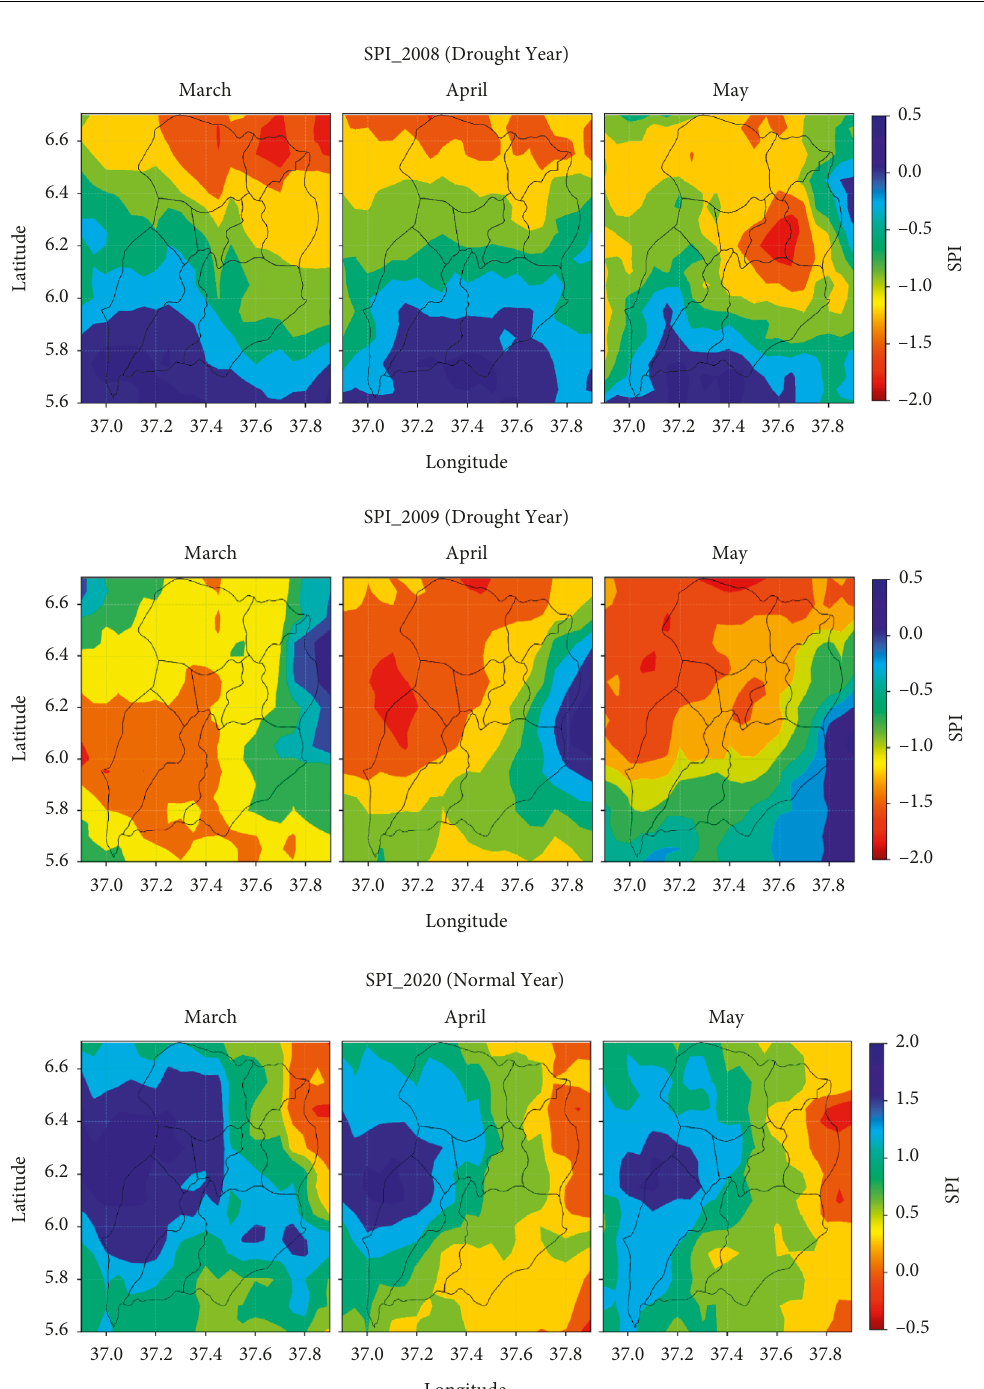
Figure 6: Spatial distribution of SPI for rainy season (March–May) of 2008, 2009, and